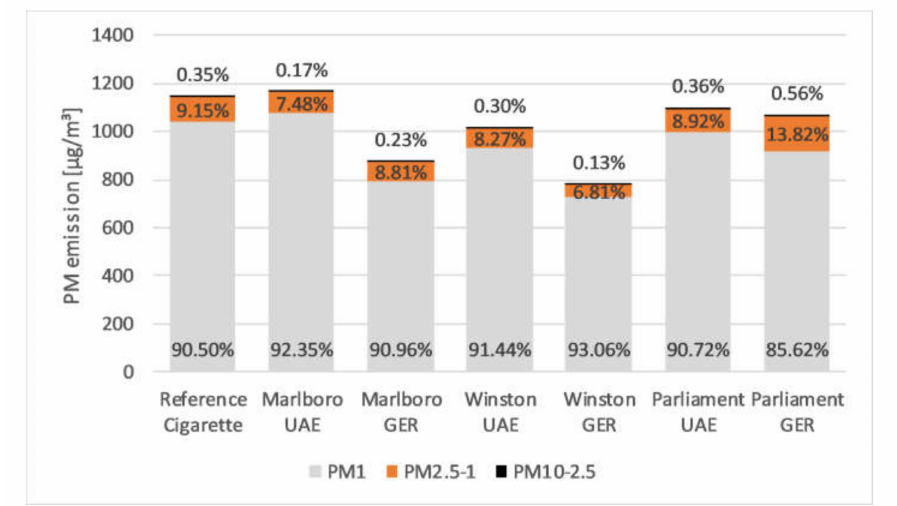
Figure 2. Distribution pattern of PM 10–2.5 , PM 2.5–1 , and PM 1 in aerosol generated by the combustion of all investigated cigarettes. UAE = United Arab Emirates. GER =